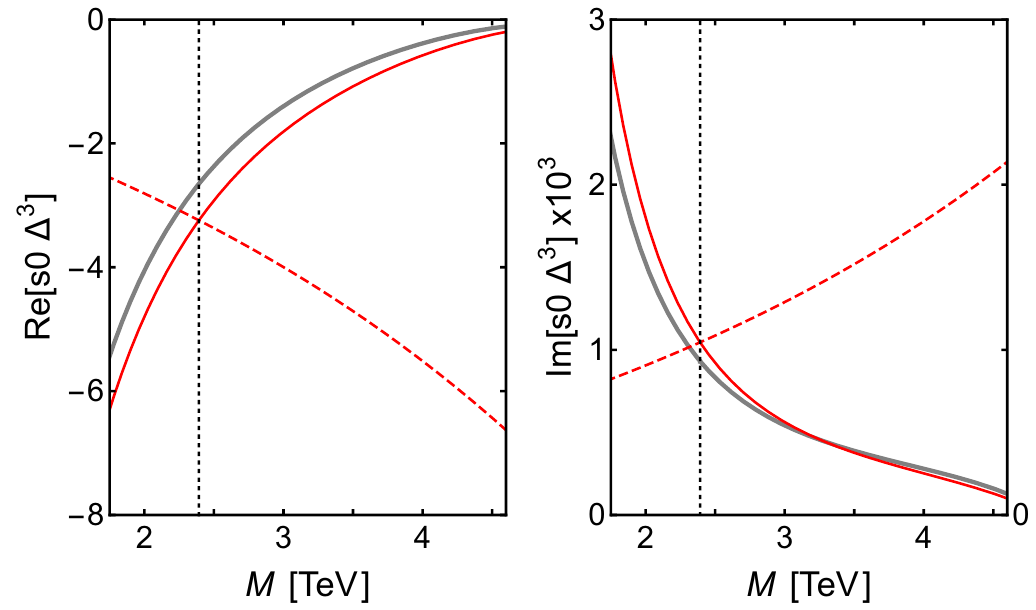
Figure 20 . Real and imaginary parts (left and right panels) of the neutral-wino shape parameter s 0 as functions of the wino mass M : NREFT (thicker grey curves), ZREFT at LO with M -dependent parameter tan (cid:30) ( M ) (solid red curves), and ZREFT at LO with constant parameter tan (cid:30) ( M (cid:3) ) (dashed red curves). The vertical dotted lines indicate the unitarity mass M (cid:3) = 2 : 39